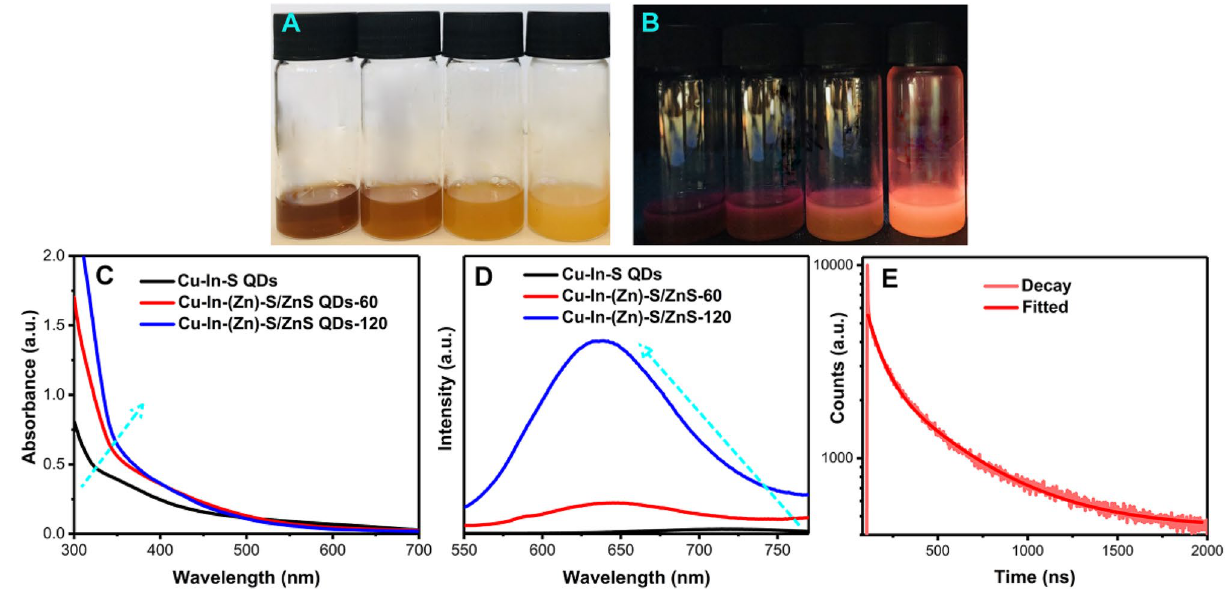
Figure 5. ( A , B ) Photographs of aliquots taken from the reaction vessel at different time intervals (from left to right, 10 min, 30 min, 60 min and 120 min) under daylight and UV lamp. ( C , D ) UV–Vis spectra and PL spectra of Cu–In–S QDs, Cu–In–(Zn)–S/ZnS-60 and Cu–In–(Zn)–S/ZnS-120, respectively. ( E ) PL decay curve of Cu– changed from brown (10 min) to bright orange (120 min) under daylight. Under a UV lamp, the sample shows increasing luminescence with the reaction time (Fig. 5B). Figure 5C shows the UV–Vis spectra of the Cu–In–S QDs, the sample Cu–In–(Zn)–S/Zn–S-60 and the sample Cu–In–(Zn)–S/ZnS-120. Due to the traditional trait of multicomponent Cu-based quantum dots, these UV–Vis spectra are featureless without any observable well- defined exciton absorption peaks for all three samples 54–56 . The enhanced absorbance and the blue shift of the onset of the absorption before 400 nm can be observed as the reaction proceeds, which is due to the increased absorption cross-section upon coating with ZnS, a wide band gap semiconductor. Therefore, the Cu–In–(Zn)–S/ ZnS “ice cream cone” heterostructures represent an effective down-converting luminescent NC. The corresponding photoluminescence (PL) spectra of the three samples are shown in Fig. 5D. The Cu–In–S QDs are emissive in the NIR region (770 nm) with relatively low PLQY (2.7%). After 60 min of ZnS shell pre- cursor solution injection, a substantial blue shift (125 nm) can be observed, shifting the emission peak from 770 nm for the Cu–In–S core to 645 nm for Cu–In–(Zn)–S/ZnS-60. When the reaction reached completion, the emission peak of Cu–In–(Zn)–S/ZnS-120 showed a further minor blue shift (7 nm) from 645 to 638 nm. Such an observed blue shift of PL peaks have commonly been reported during the synthesis of Cu-based quantum dots 42,66 particularly for Cu-based ternary or quaternary core/shell nanostructures involving Zn 60,61,66–69 . It was found that Zn(St) 2 was the most effective precursor for achieving a blue shift among a range of Zn precursors for the preparation of CuInS 2 /ZnS core/shell quantum dots, including zinc chloride, zinc acetylacetonate and zinc acetate reported by Jaehyun park and Sang-Wook Kim 61 . The mechanisms underlying this PL blue-shift phenomena during the synthesis are not clearly established, with several pathways having been proposed such as: (1) Filling up of intra-bandgap defect states 65,70 , (2) Core size reduction by cation exchange 59–61,71 and (3) Band gap widening by the entrance of Zn ions 72 . The first mechanism is mainly about passivation by means of ZnS shelling, which facilitates the reduction of the fraction of donor–acceptor recombination pathways with lower energy levels; thus the band-edge or band to donor/acceptor emission with higher energy levels becomes the dominant emissive deexcitation pathway, leading to the observed blue shift. Core size reduction by cation exchange 59–61,71 is proposed to occur due to the similar sizes of the metal cations present of Cu, In and Zn. Since the reaction takes place at high temperatures, Zn 2+ can diffuse into the Cu-based ternary or quaternary core lattice structure and can replace the Cu 1+ and In 3+ ions, therefore reducing the size of the core and resulting in core-size dependent blue shift. Finally, band gap widening by the entrance of Zn ions into the lattice 72 can take